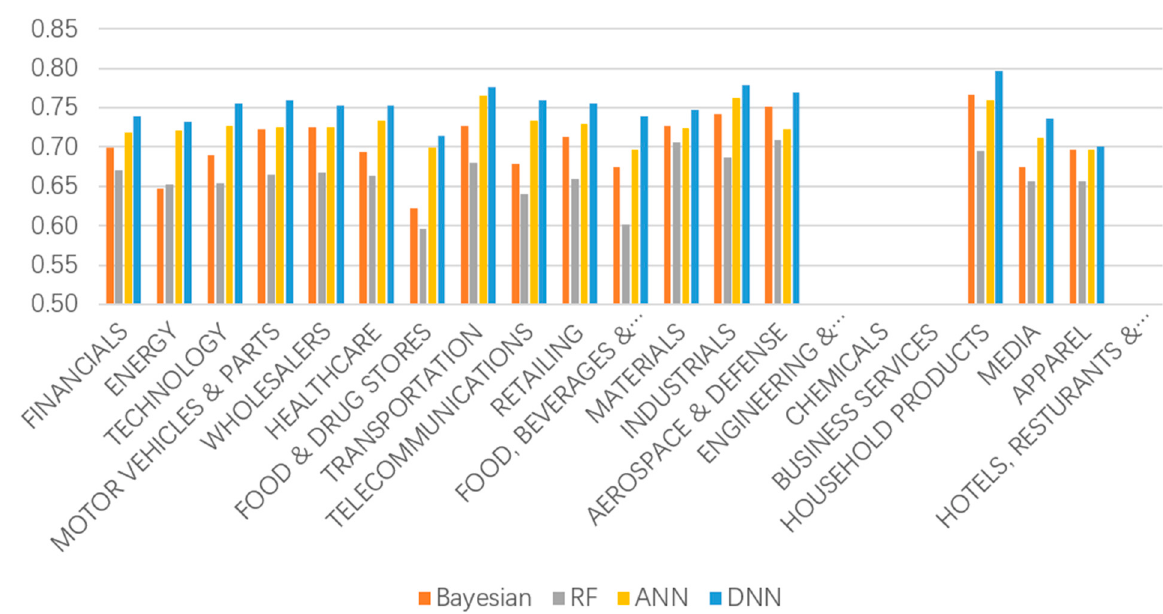
Figure 9. The evaluation of predictive accuracies in industries.